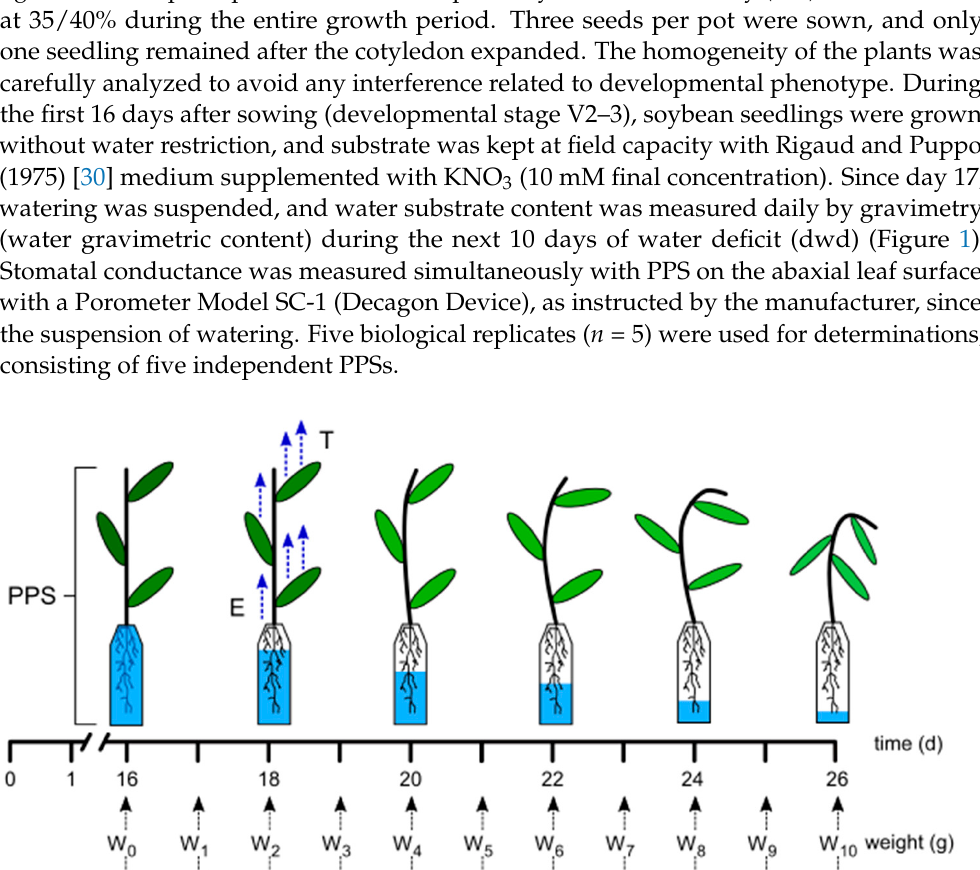
= = until 10 t ). Evapo-